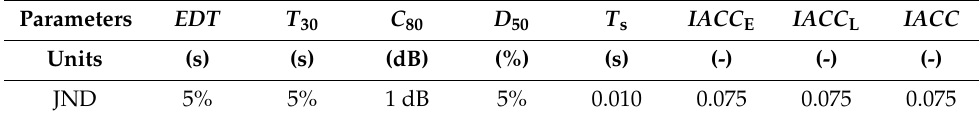
Table 2. Objective acoustic parameters and respective JND values.